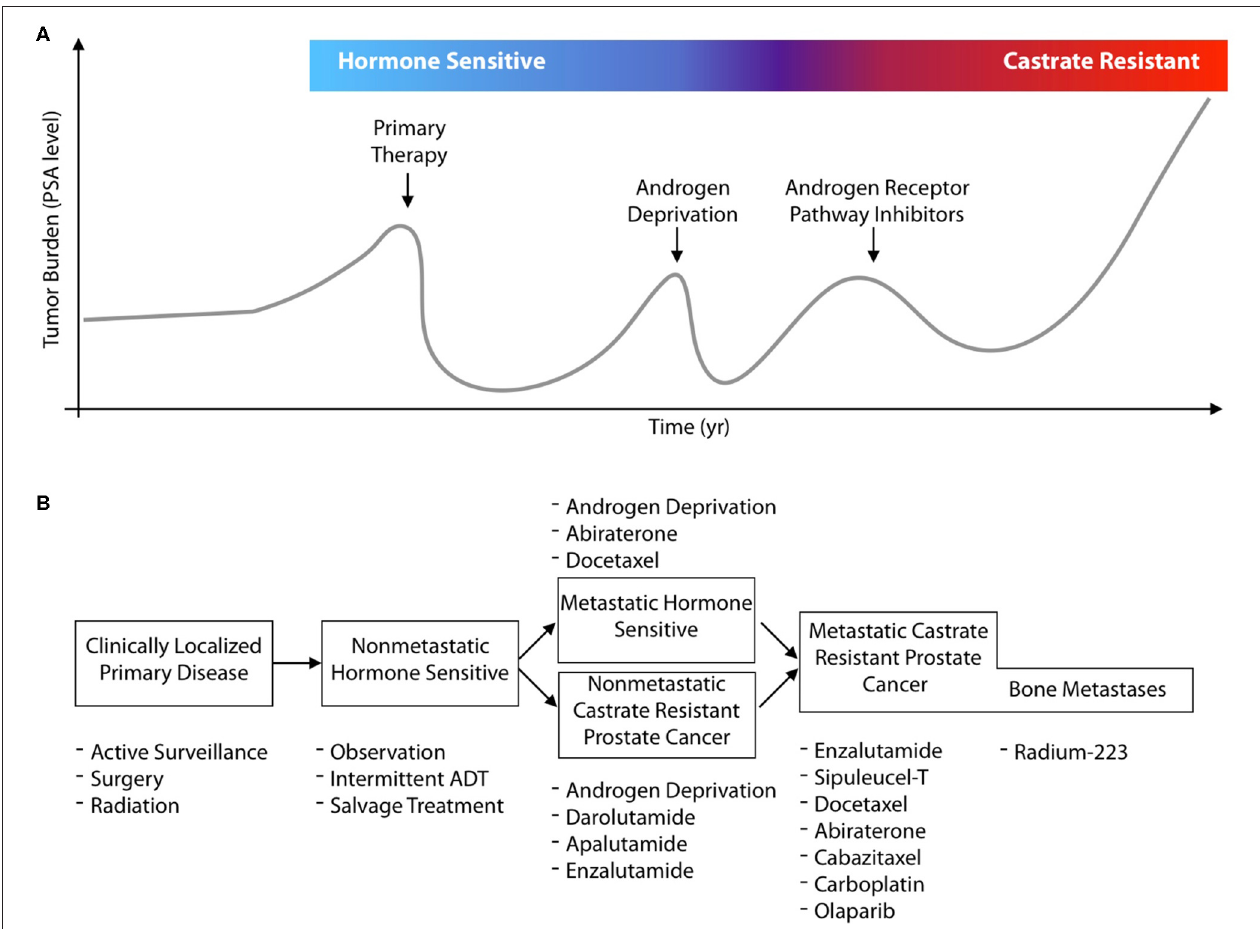
FIGURE 1 | Contemporary prostate cancer states and systemic treatments. (A) Adenocarcinoma arising in the prostate gland is the second most common cancer in males, and can be cured with local intervention if detected when still localized to the organ. Disease is often detected by serum PSA measures which also enable tracking of disease recurrence should initial therapy and subsequent lines of treatment fail. Most commonly, disease control is attempted with hormonal control of the androgen receptor signaling access through (chemical) castration and the use of androgen receptor inhibitors. (B) The last decade has seen the approval of 8 new agents for prostate cancer across different disease states. These approvals result from significant survival benefits for patients at multiple lines of treatment. However, the eventual progression on novel antiandrogens, Radium-223, and chemotherapies leave considerable room for improvement. Despite the number of existing treatment options, efforts with molecularly targeted radiotherapies are under intense, global, evaluation; as well as to use new imaging agents to better guide drug development and more accurately characterize